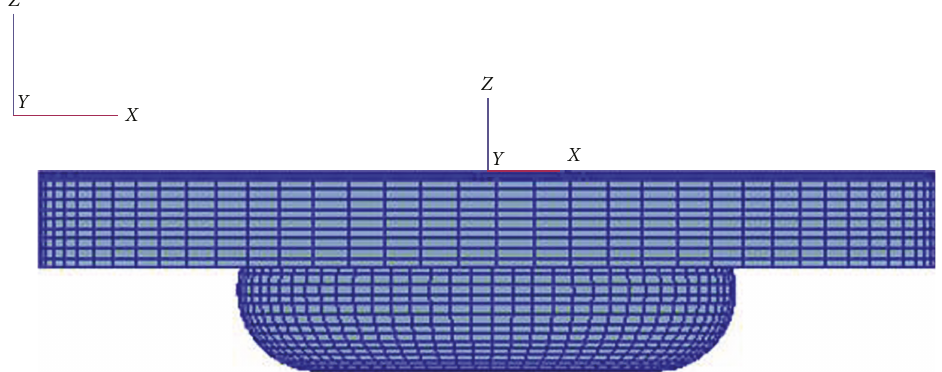
Figure 1: The meshes of the combustion chamber under 740 ° CA.